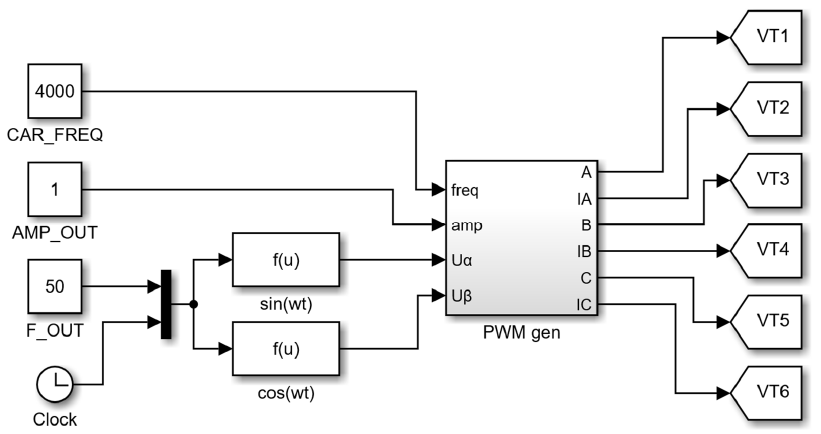
Figure 4. Simulink-model of the inverter control system unit.